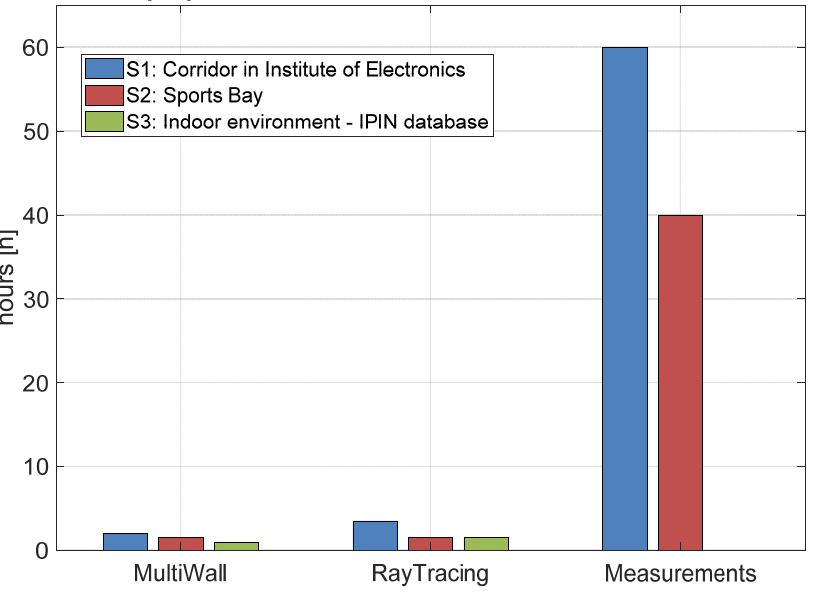
Figure 19. Time required to prepare reference datasets by selected methods (no data for IPIN).